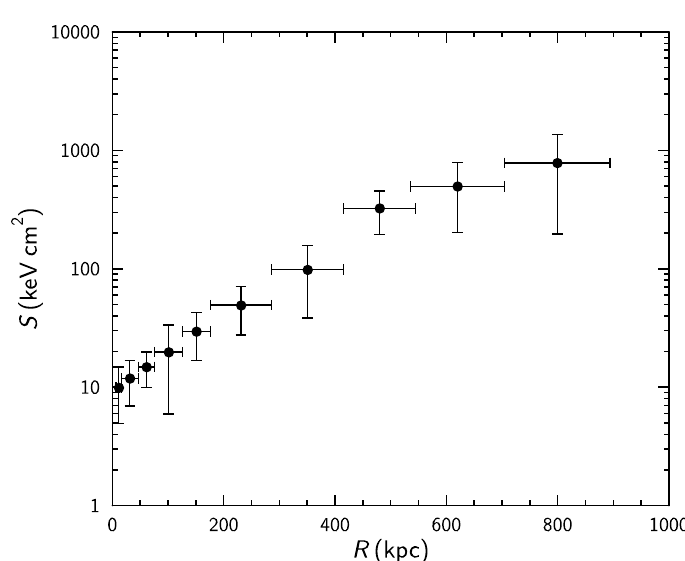
Fig. 3. The observed entropy pro(cid:12)le of CLJ1415 obtained from the deprojected tem- perature and density pro(cid:12)les. where S ( r ) is the X-ray surface brightness profile as a function of the projected radius r , S 0 , r c , (cid:12) and C are free parameters in fitting the model to the